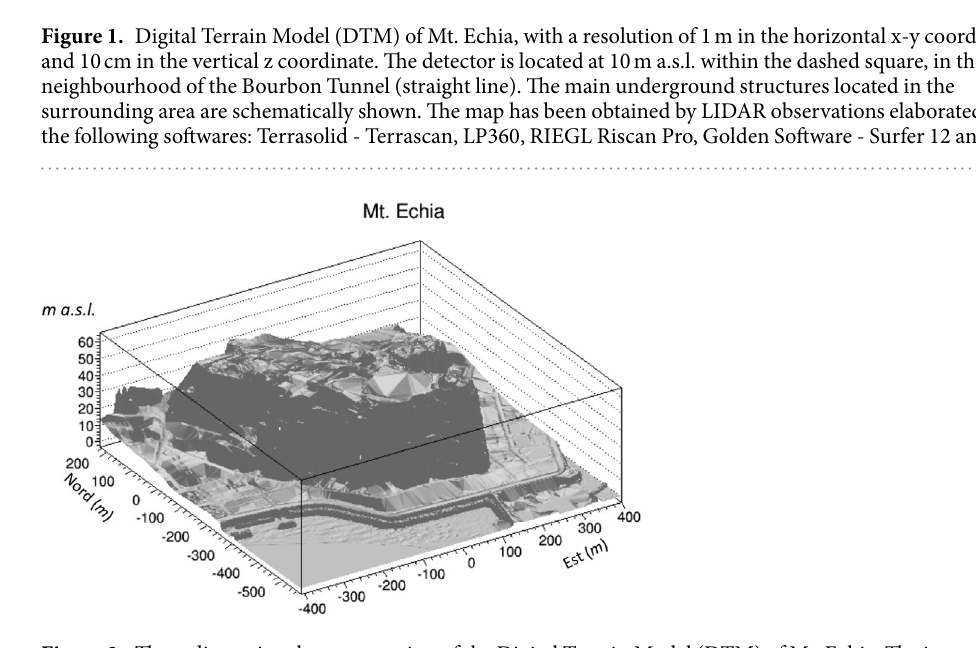
Figure 2. Three dimensional representation of the Digital Terrain Model (DTM) of Mt. Echia. The image was obtained using LIDAR observations elaborated by the following softwares: Terrasolid - Terrascan, LP360, RIEGL Riscan Pro, Golden Software - Surfer 12 and root